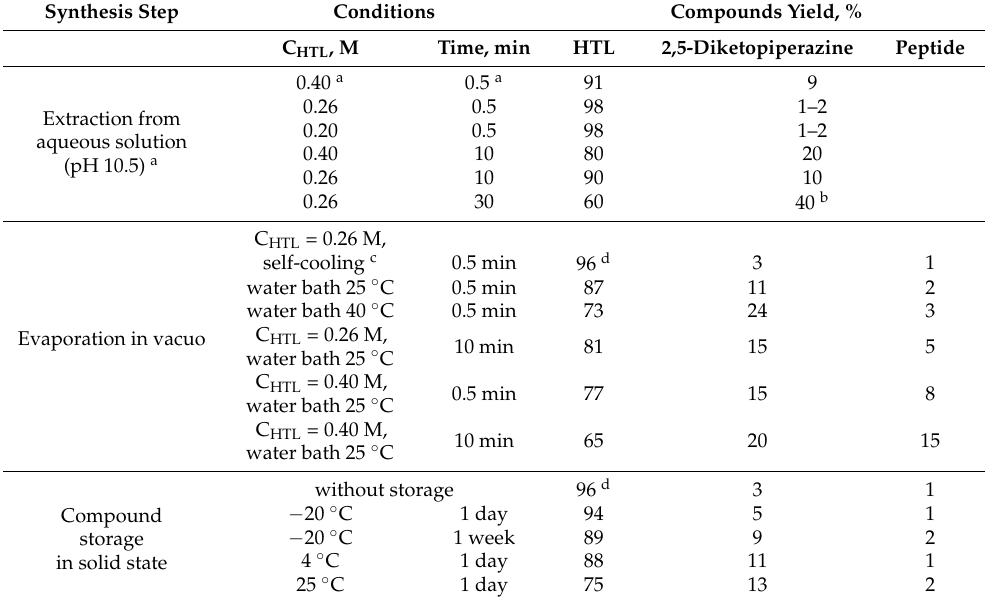
Table 1. A brief summary of HTL free base synthesis